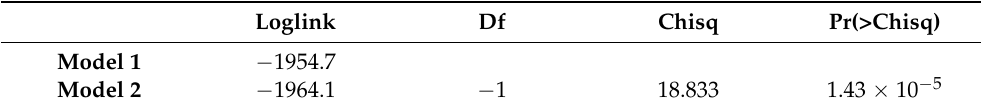
Table 7. Results of the Likelihood Ratio Test (LRT). Loglink